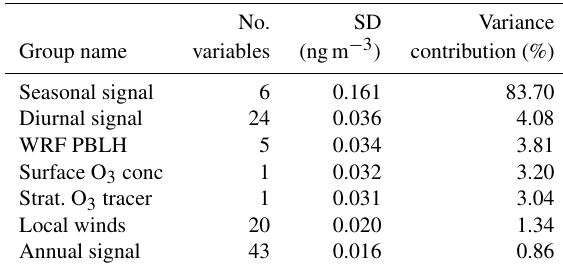
Table 3. Contribution from the different groups to the total vari- ance of the model. The standard deviation of each group gives a sense of the contribution of each group to the variance in units of ngm − 3 . The variance contribution shows the percentage that each group contributes to the total variance of the